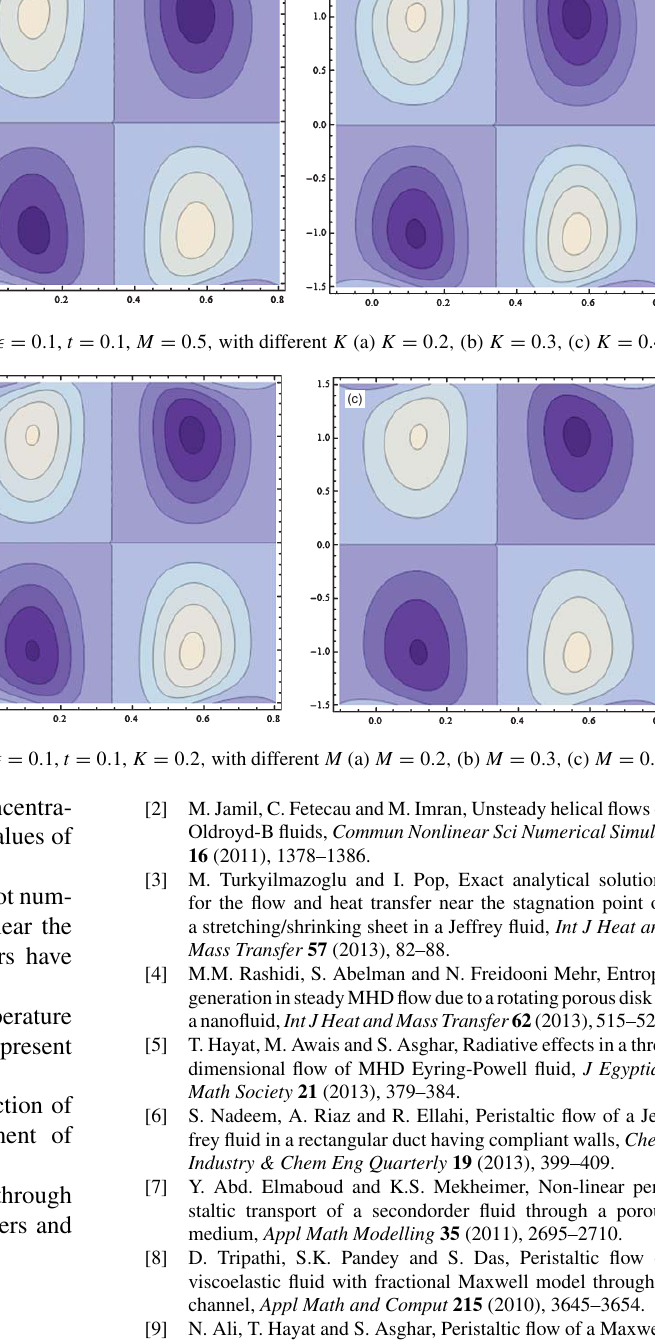
Fig. 26. Streamlines for E 1 = 0 . 2, E 2 = 0 . 1 , E 3 = 0 . 1, (cid:15) = 0 . 1, t = 0 . 1, M = 0 . 5 , with different K (a) K = 0 . 2 , (b) K = 0 . 3 , (c) K = 0 . 4 .